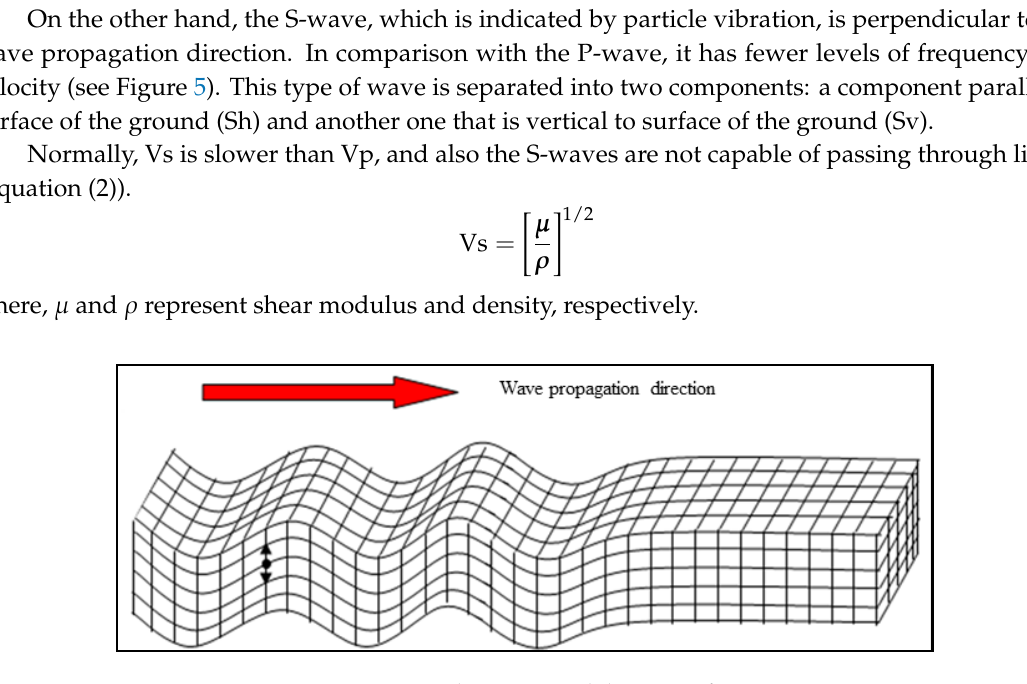
Figure 5. S-waves; particle motion and direction of propagation.